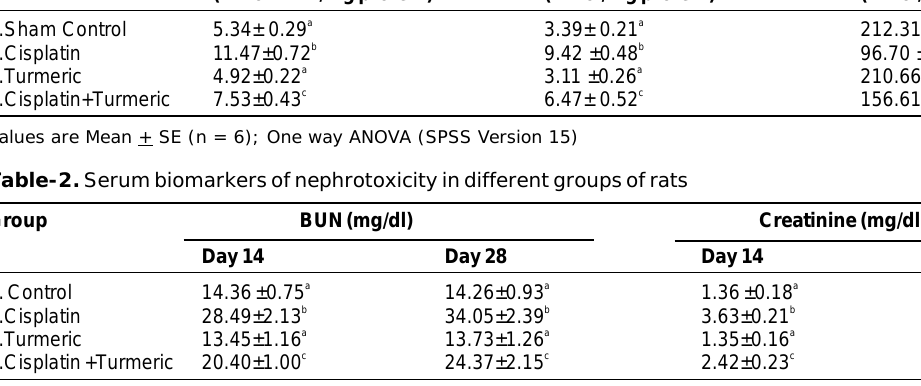
Values are Mean + SE (n = 6); One way ANOVA (SPSS Version 15) Values with different superscripts differ significantly (P<0.05) in the same column